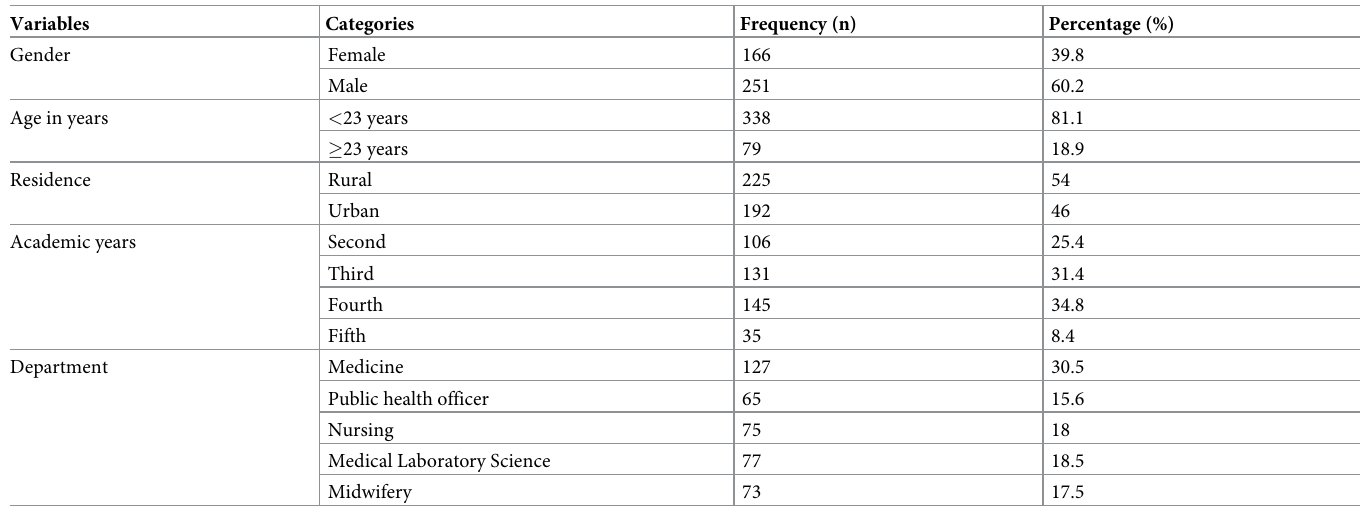
Table 1. Socio-demographic and other related characteristics of study participants at the Wolkite University, southwest Ethiopia, 2020 (n = 417).